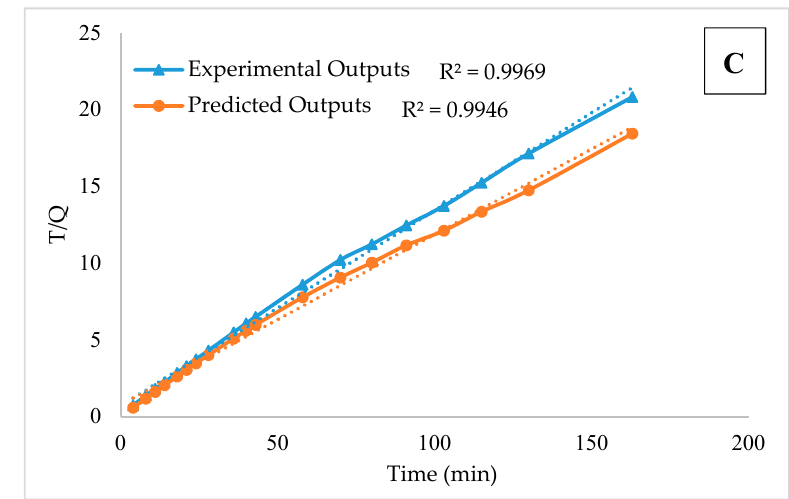
Figure 4. Kinetic analysis for the experiment ( A ) 20 mg of adsorbent dosage, 3 mg / L of initial mercury concentration, pH of 3; ( B ) the adsorbent dosage used is 20 mg, the concentration of mercury ions is 5 mg / L, the selected pH is 6 and ( C ) the adsorption capacity is 30 mg, the initial concentration of mercury ions is 5 mg / L, the used value of pH is 6.